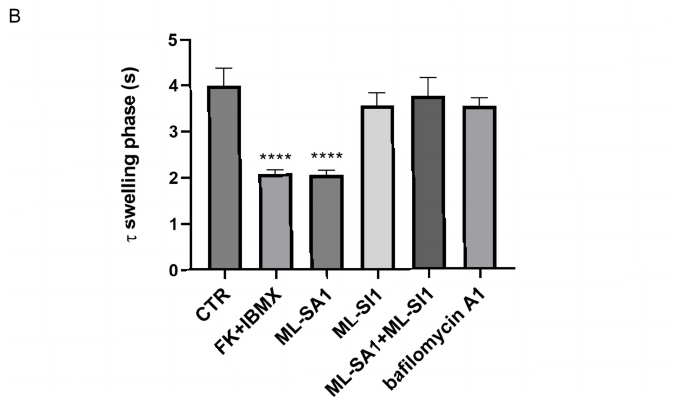
Figure 7. ML-SA1 and bafilomycin A1 differentially modulate the swelling phase of MCD4 cells under hypotonic condition. ( A ) Representative time courses of cell swelling phases recorded from calcein-loaded cells left untreated or stimulated as follows: 100 µ M FK+ 500 µ M IBMX for 15 min; 100 µ M ML-SA1 for 15 min; 25 µ M ML-SI1 for 30 min either alone or followed by a co-incubation with ML-SA1; 100 nM bafilomycin A1 for 30 min. The time course shows changes in fluorescence (expressed in arbitrary units, rfu) over time (s) elicited by hypotonic stimulation ( ∆ 60 mOsm/L) as indicated. The arrows indicate the switch in the external osmolarity; ( B ) Quantitative analysis of the cell swelling time constants ( τ ) in MCD4 cells. Data were obtained from 3 independent experiments. multiple comparisons test. **** p <